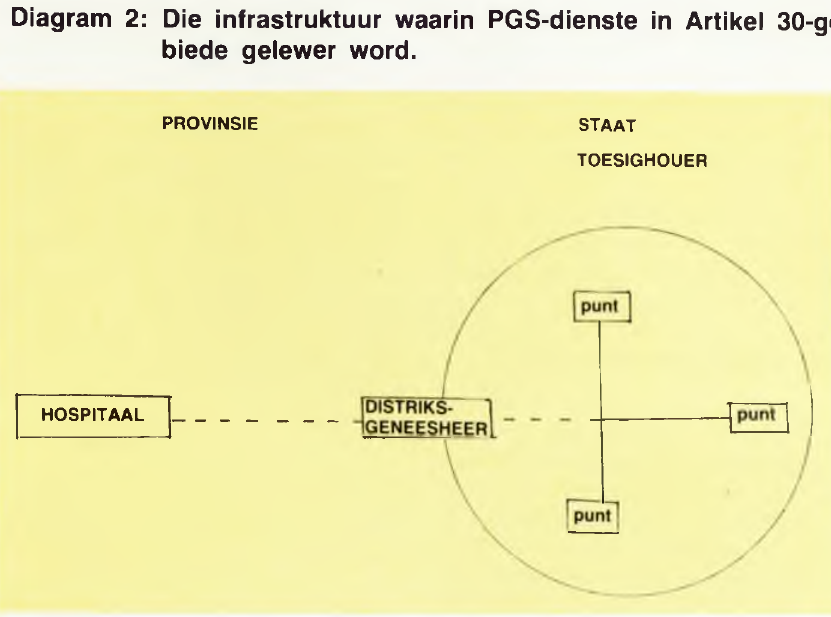
Diagram 2: Die infrastruktuur waarin PGS-dienste in Artikel 30-ge- biede gelewer word.